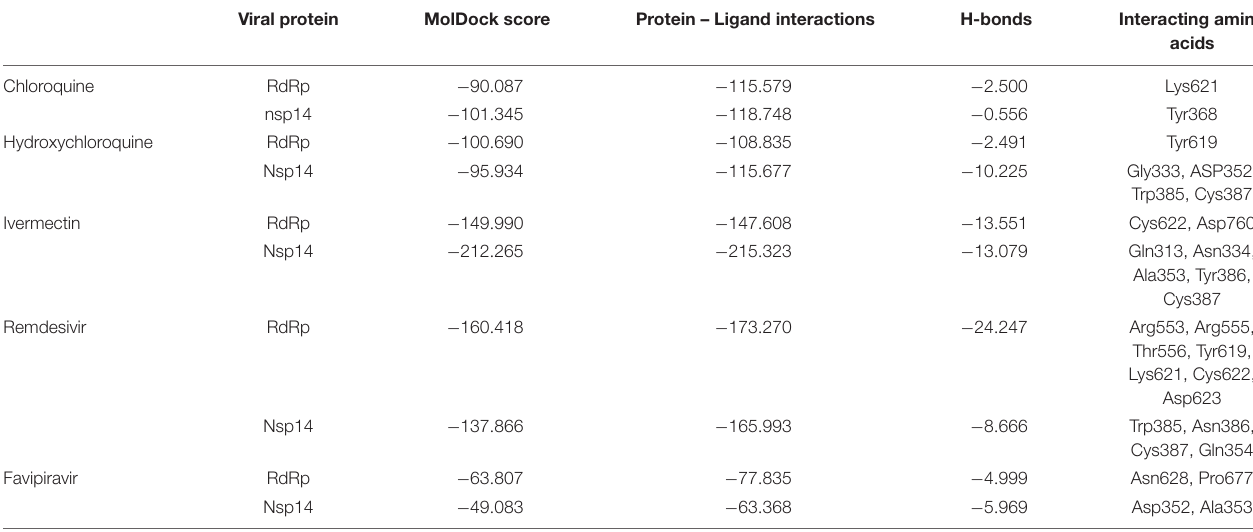
TABLE 2 | Docking of the RdRp and nsp14 to selected